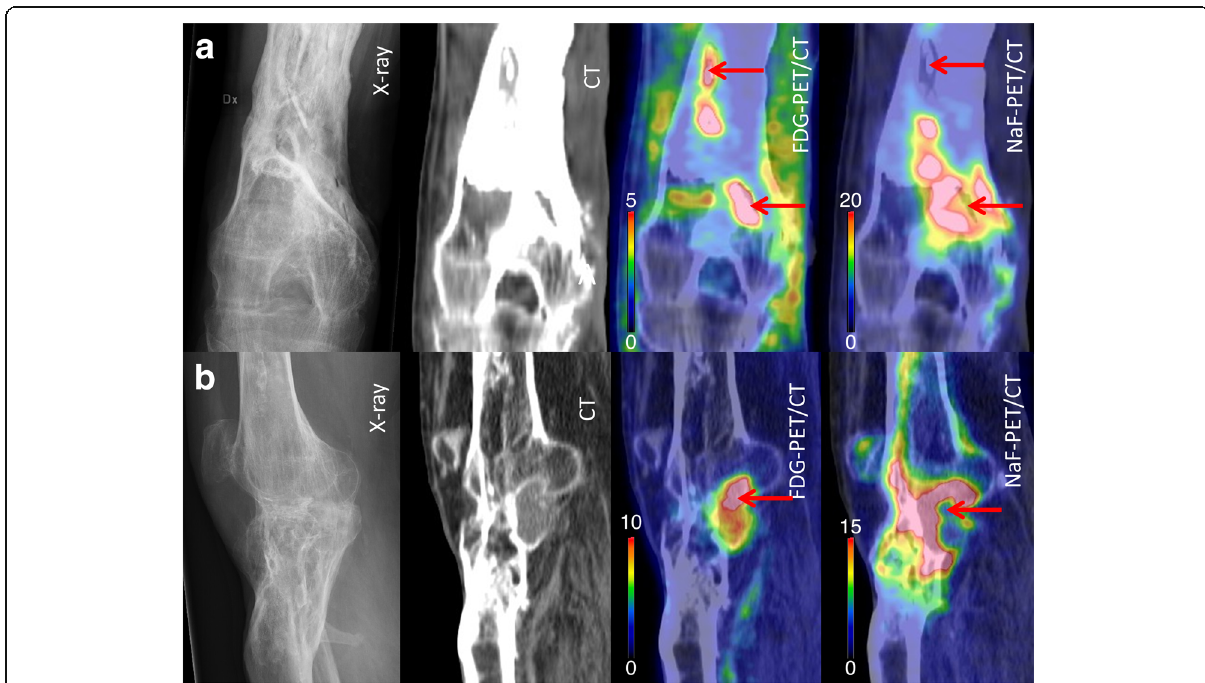
Fig. 1 Preoperative images (X-ray, CT, FDG-PET/CT, and NaF-PET/CT) of chronic osteomyelitis in distal femur in two different patients. The arrows point at bone segments with high uptake on FDG-PET/CT ( “ hot spots ” ) and low uptake on NaF-PET/CT ( “ cold spots ” ). The findings are best visualized in coronal views in patient ( a ), where two sequestra were found, and in sagital views in patient ( b ), where one sequestrum was